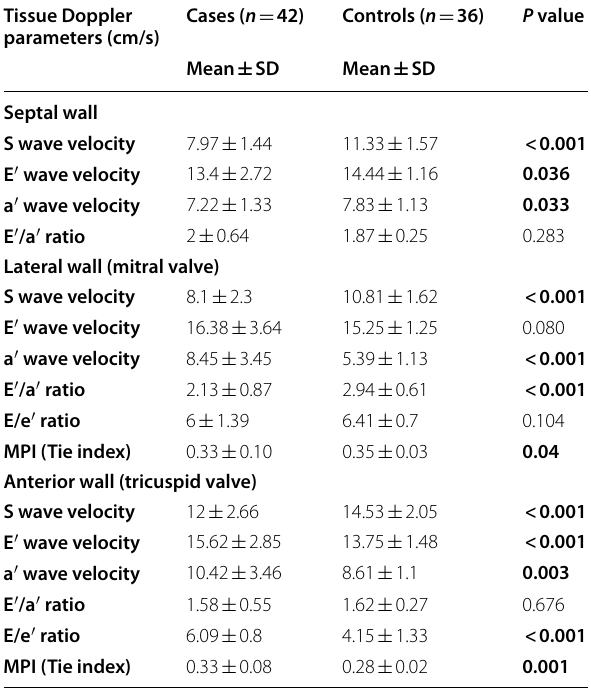
SD standard deviation, P > 0.05 nonsignificant (NS), P < 0.05 significant (S), P < 0.01 highly significant (HS), MPI myocardial performance index